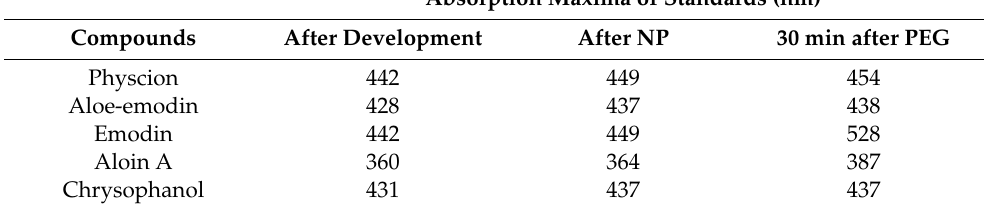
Table 1. Absorption maxima of standards determined by densitometric scanning of the HPTLC silica gel plate developed with toluene–acetone–formic acid (3:6:1, v / v ). Spectra were scanned after development, after post-chromatographic derivatization with NP reagent and 30 min after the application of PEGreagent.